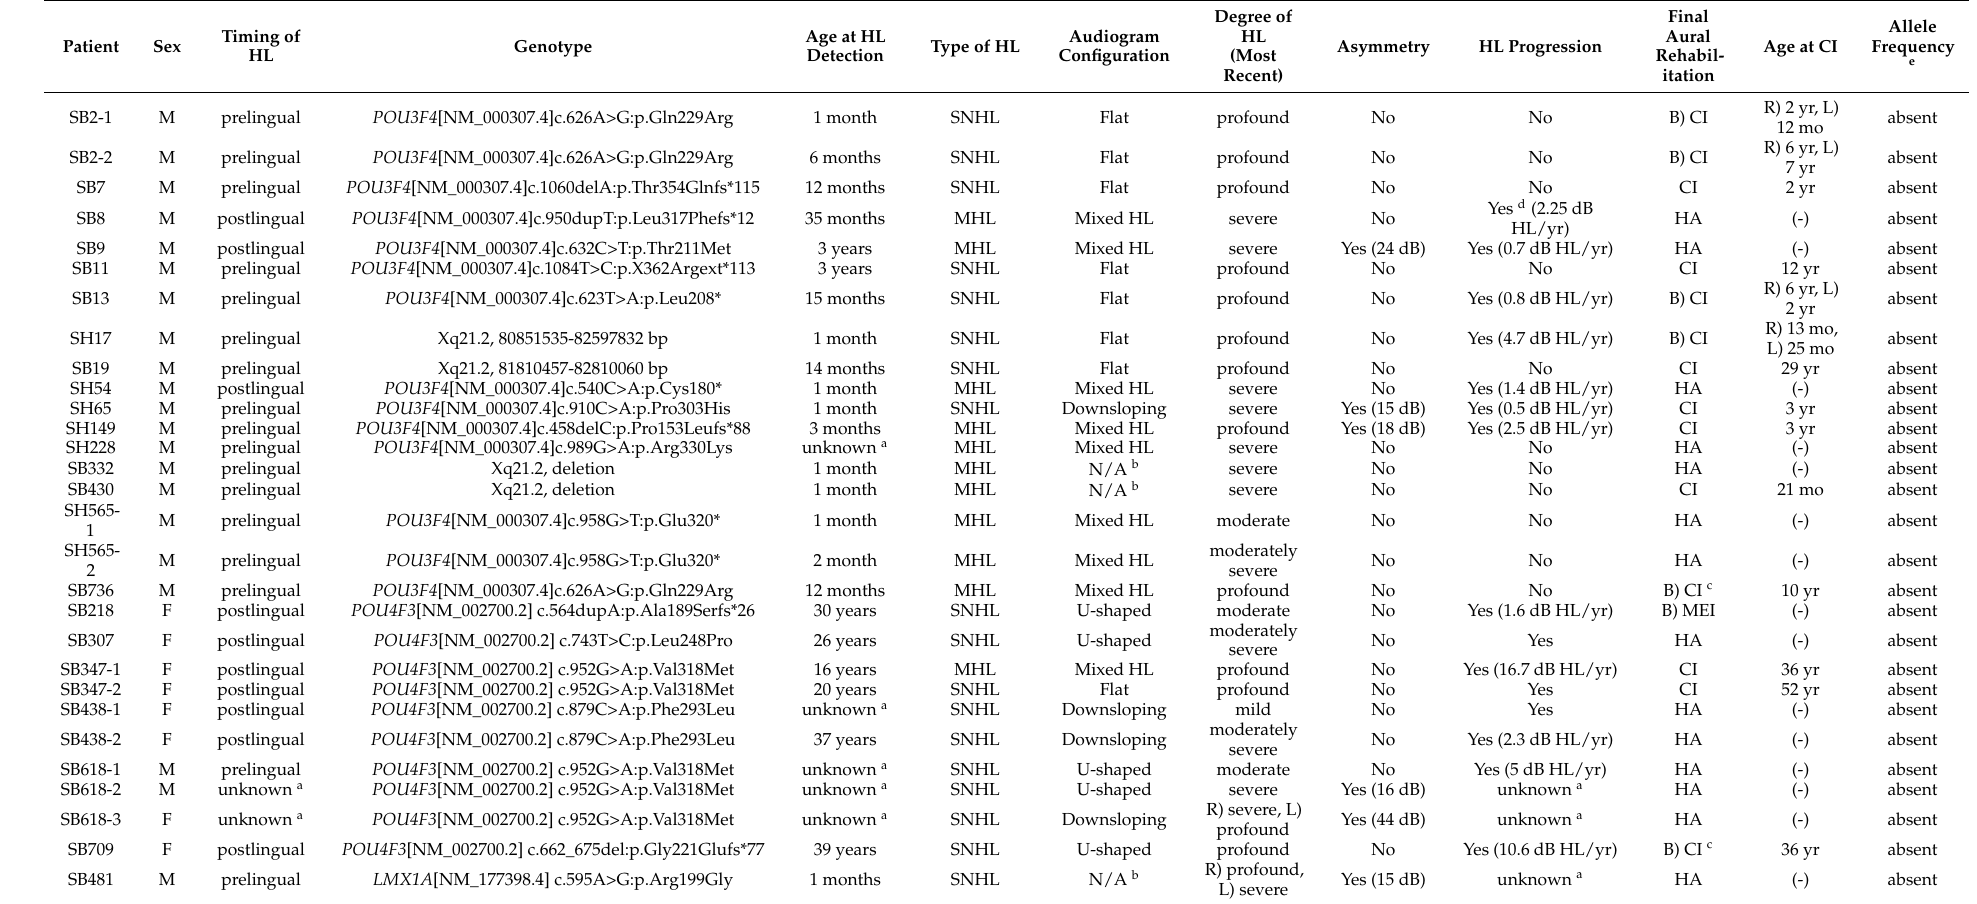
Table 1. Phenotypes and genotypes associated with non-syndromic deafness caused by transcription factor